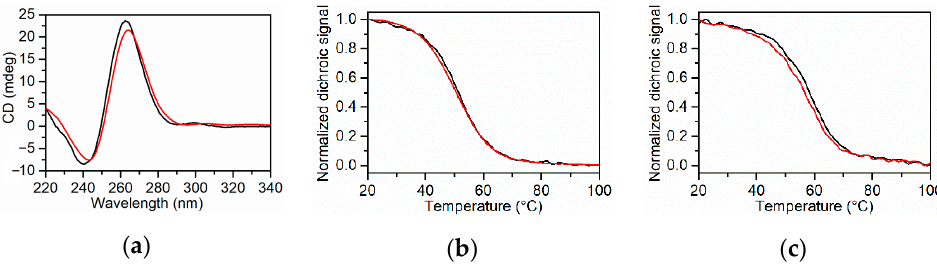
Figure 2. ( a ) Circular dichroism (CD) spectra of KRAS 22RT (black line) and KRAS 32R (red line). CD melting (black line) and annealing (red line) profiles of ( b ) KRAS 22RT and ( c ) KRAS 32R at 0.5 °C min − 1 . The buffer solution was 20 mM KH 2 PO 4 /K 2 HPO 4 with 60 mM KCl and 0.1 mM EDTA at pH 7.0.